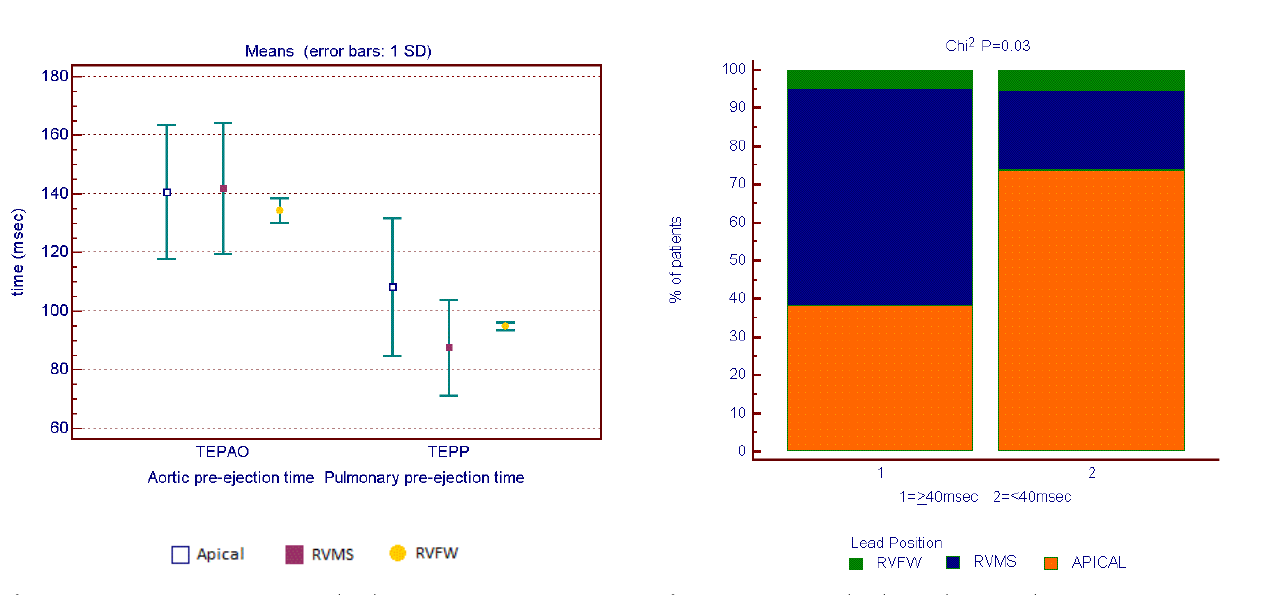
Fig. 7 - Aortic pre-ejection time and pulmonary pre-ejection time according to pacing site .